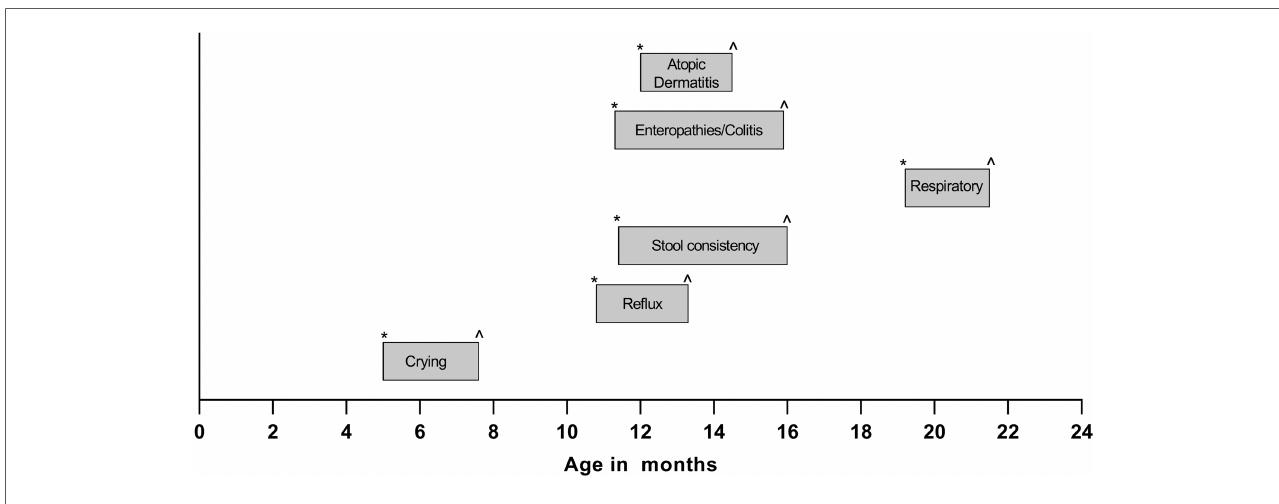
FIGURE 3 Average age-range of reported onset (*) and resolution (^) of symptoms in both